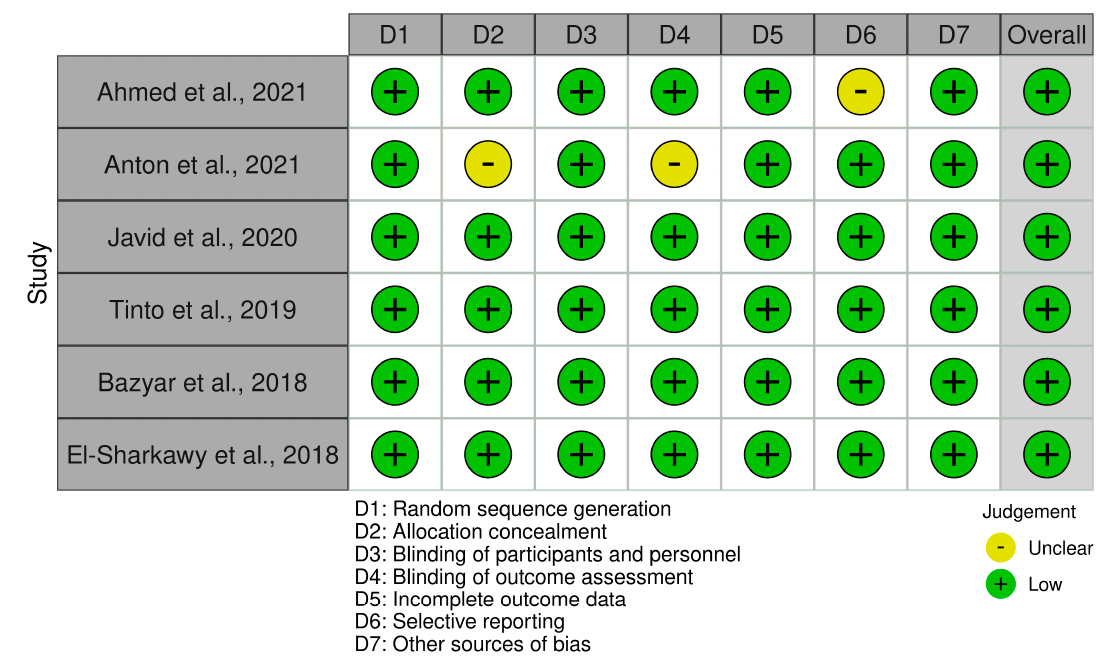
Figure 2. Risk of bias for 6 included articles [30–35].